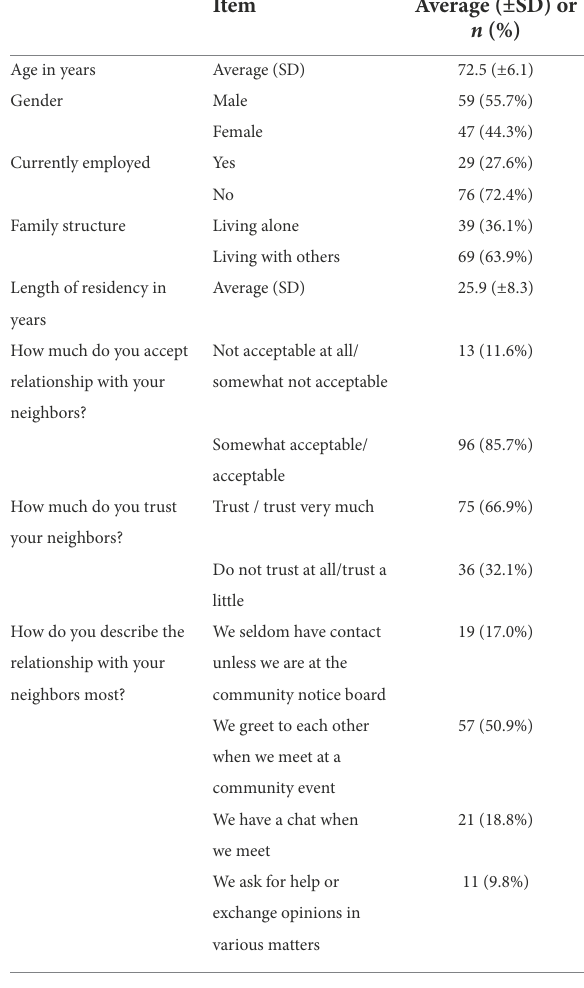
TABLE 1 Social-demographic characteristics of participants ( N =